Question: Condense the content of this figure into a single sentence.
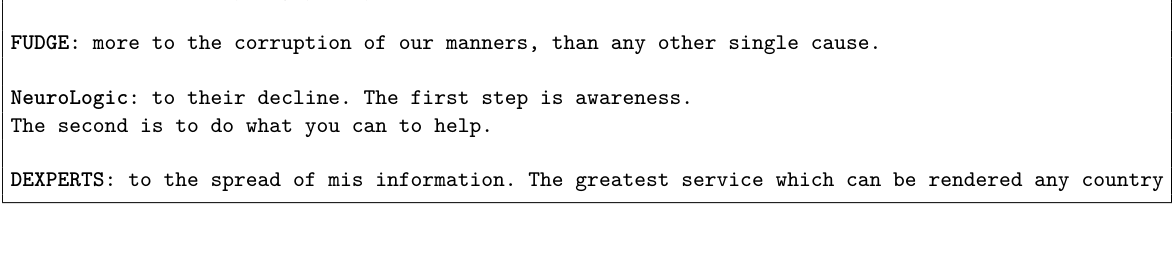
Answer: Randomly selected example with low sentiment score (as determined by human annotation.)